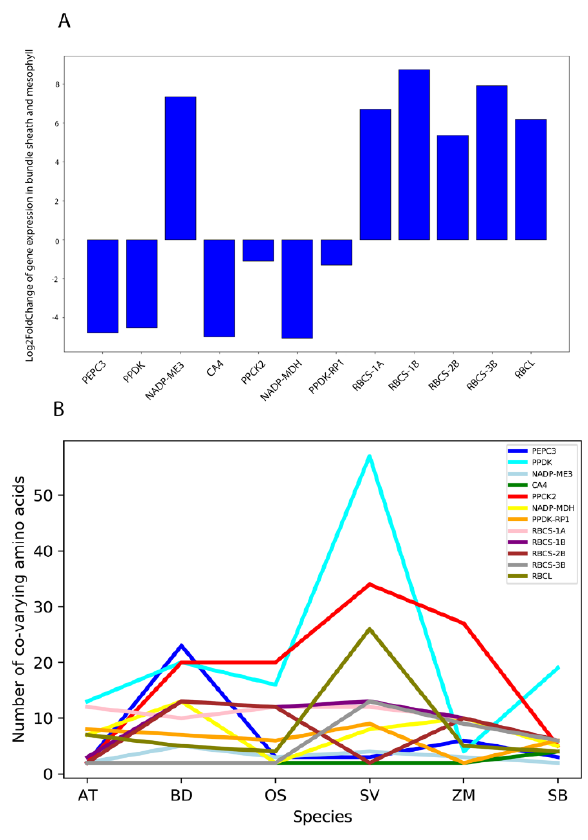
Figure 5. Selection of C4 candidates in carbon delivery chain and the identification of their global co-varying sites. ( A ) Differential expression patterns of selected C4 candidates that are responsible for carbon delivery in Setaria viridis, based on their expression preferences in bundle sheath and mesophyll cells. The blue columns represent their log2FoldChange of expression values. ( B ) Global co-varying site identification in these enzymes based on mutual information theory. The numbers of co-varying sites in each amino acid sequence are plotted for every C4 candidate. Each line illustrates the fluctuations of each C4 enzyme in six model